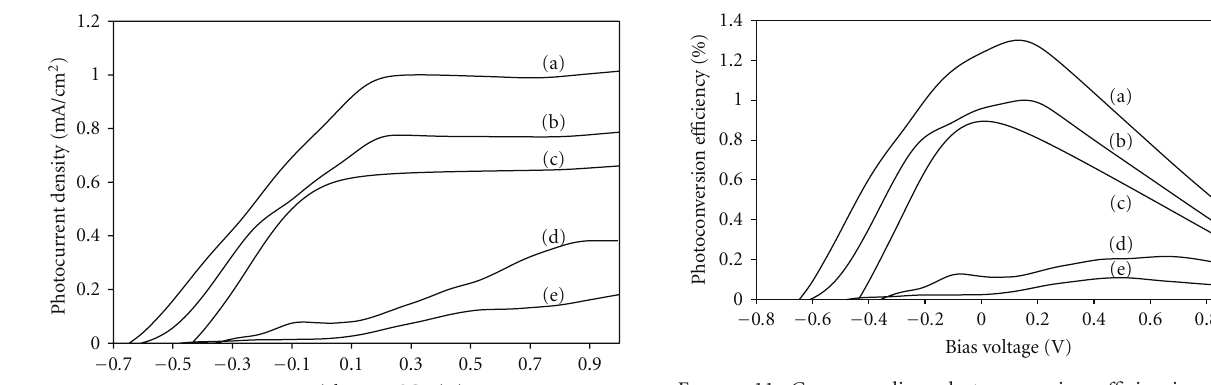
Figure 11: Corresponding photoconversion e ffi ciencies of TiO 2 nanotubes at (a) room temperature, (b) 40, (c) 60, (d) 10, and (e) 80 ◦ C anodization